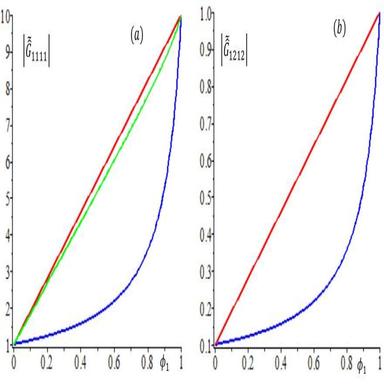
Magnitude of the dimensionless constitutive tensor ˜ Gˆijhk, obtained with the homogenized model (green), is compared with the Voigt-Reuss bounds in terms of φ1 = η η+1 : (a) | ˜ Gˆ1111|; (b) | ˜ Gˆ1212|. The values of dimensionless parameters are fixed as: rE = rρ = τ i ς = sς = 10, i = 1, 2, ν˜1 = ν˜2 = 0.2 and γ = 1. (For interpretation of the references to colour in this figure legend, the reader is referred to the web version of this article.)